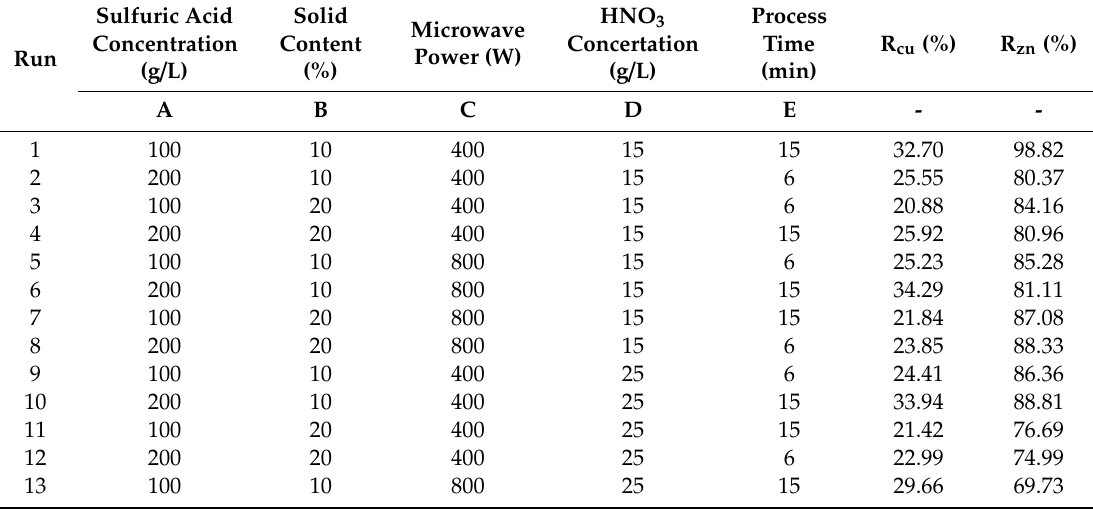
Table 5. Central composite experimental design and response